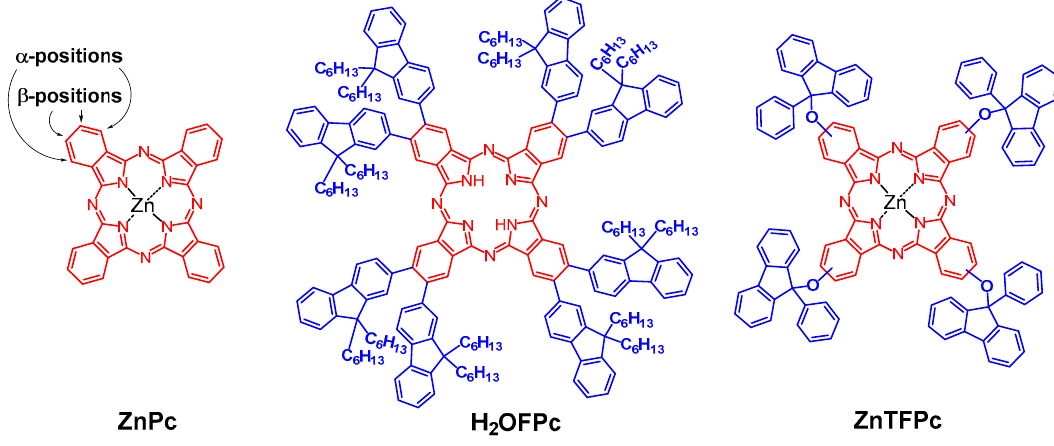
Figure 2. Zinc(II) phthalocyanine ( ZnPc ) (with ring-substitution positions indicated), free phthalocyanine octasubstituted by eight fluorenyl antennae ( H 2 OFPc) , and zinc(II) complex of a phthalocyanine tetrasubstituted by four fluorenyl antennae at β -positions ( ZnTFPc ). Thus, in spite of its remarkably high fluorescence quantum yield ( Φ F = 88%) [30], H 2 OFPc (Figure 2) suffers from a poorly efficient energy transfer (ET) from the fluorenyl-based antennae toward the central macrocycle, possibly due to the unfavorable conformations adopted by the peripheral antennae relative to the central phthalocyanine core, these conformations being likely induced by steric strain. This steric congestion results from octasubstitution at the β -positions and from the long n -hexyl chains at the nine positions of the 2-fluorenyl units, the latter being required to solubilize this compound. In this respect, tetrasubstitution at the α - or β -positions by 2-methoxyfluorenyl units might be more favorable to promote energy transfer while maintaining solubility. Indeed, Hanack